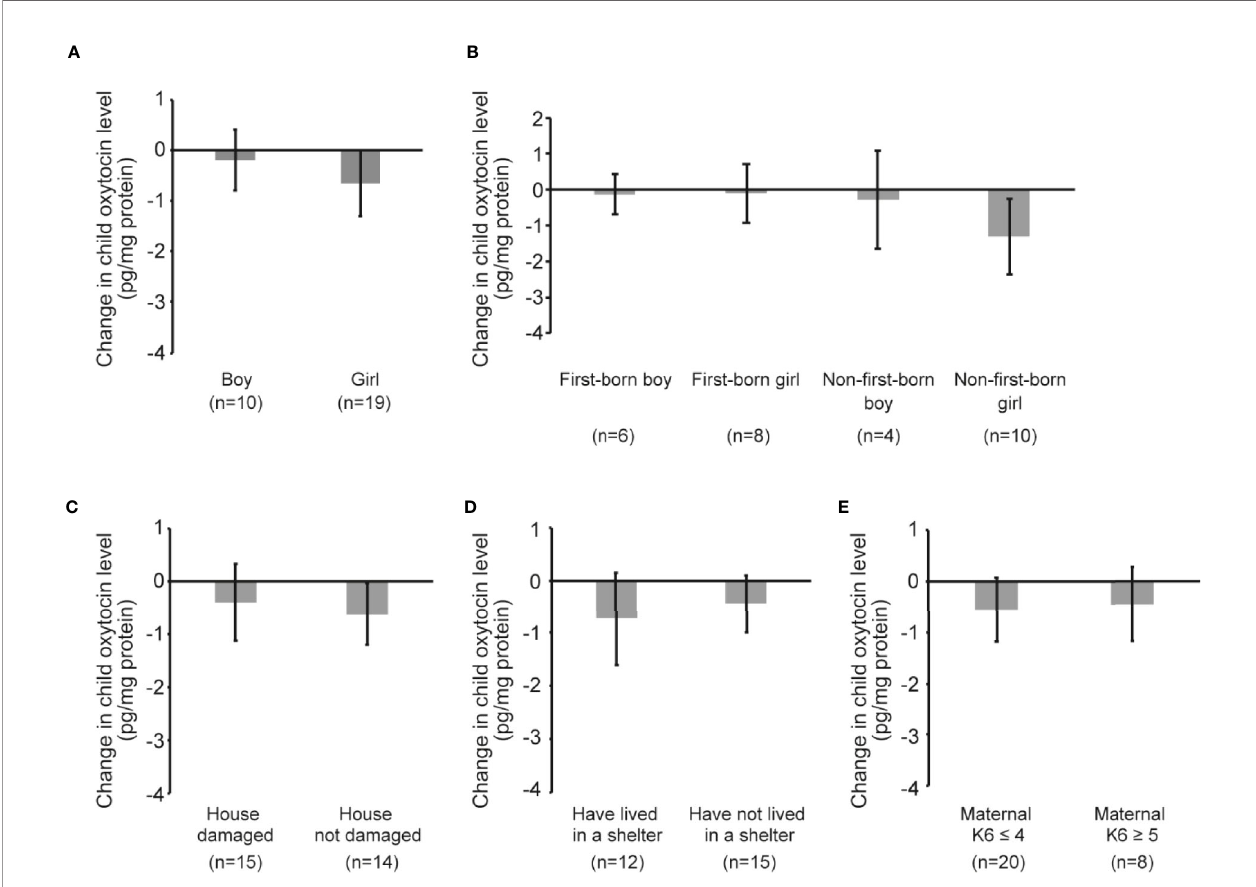
FIGURE 4 | Child oxytocin response following playful mother – child interaction. (A) Change in child oxytocin levels by playful mother – child interaction by stratifying by sex of the child. (B) Change in child oxytocin levels by playful mother – child interaction by stratifying by sex of the child as well as the birth order of the child. (C) Change in child oxytocin levels by playful mother – child interaction by stratifying by the presence of damage to the house by the earthquake. (D) Change in child oxytocin levels by playful mother – child interaction by stratifying by the maternal experience of having lived in a shelter after the earthquake. (E) Change in child oxytocin levels by playful mother – child interaction by stratifying by maternal psychological distress as assessed by K6 score ( ≤ 4 vs ≥ 5). All data and graph bars are expressed as the mean ± standard error. Saliva oxytocin values are in pg/mg